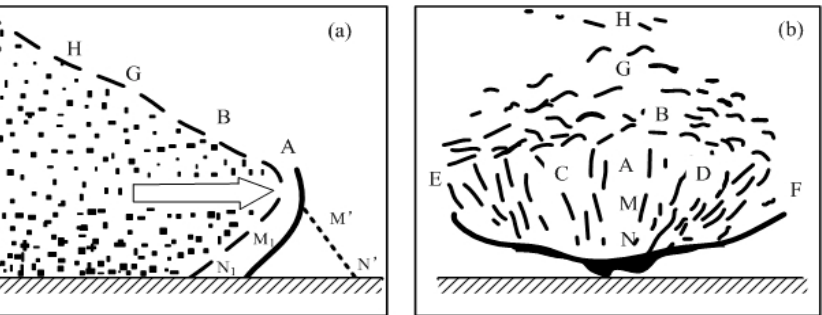
Figure 4. The front features of a LSS event. ( a ) Side view diagram. Due to the ground friction and other retardation, the wedged front of the cold air is not directly grounded like a dashed line AM’N’, but is shaped like a nose (line BAMN) that folds backwards. A is the nose tip. ( b ) Main view dia- gram. The front view is the CD portion of the nose tip of the cold air, which is just a small segment of the curved cold air pushing forward. To the left and right sides to E and F, up to G and H, down to M and N, the dense sand edge and its inner rolling gradually become blurred. The uneven layers, deep or shallow, are caused by separated process of different sized dust particles. (The Figure was reproduced from Lu, Q. and Yang, Y.L. 2001, p.